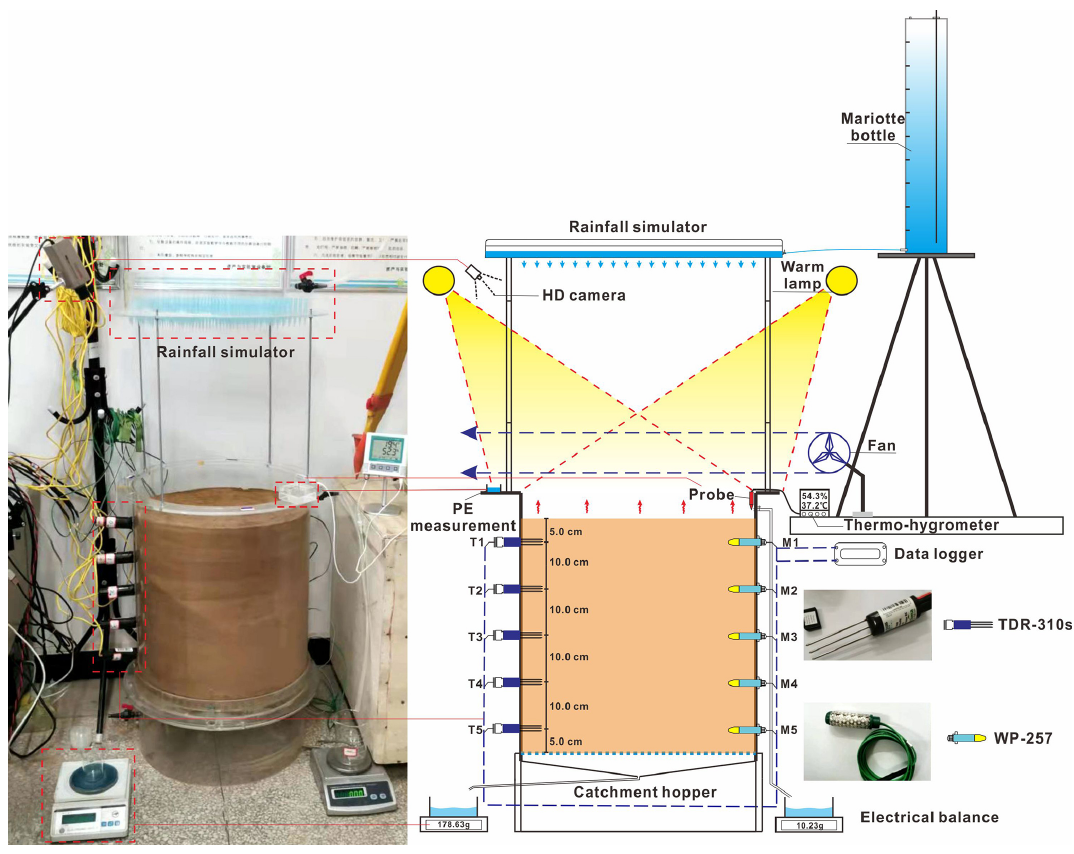
Figure 1. Schematic design and photos of the soil column test. Table 1. Basic physical parameters of the soil